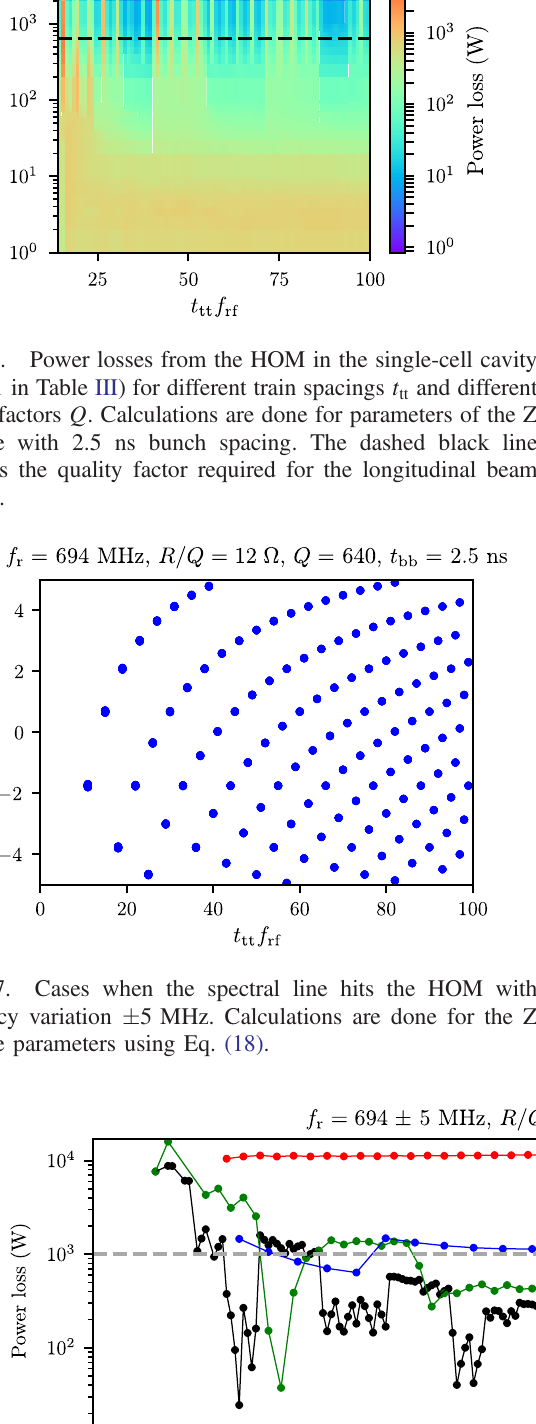
¼ 5 , 12.5, 15 ns the behavior of the power bb ¼ 7 . 5 bb